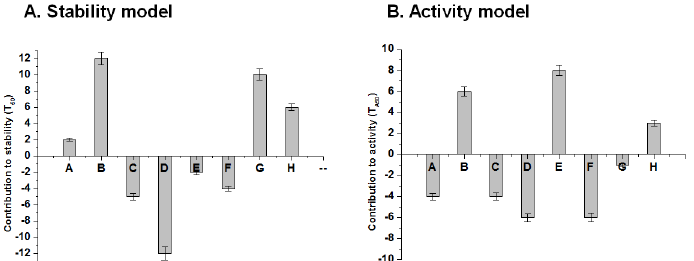
Fig 2. Modeling of thermostability and thermoactivity of GH5 chimeras. (A) Stabilizing or destabilizing effects of 8 noncontiguous blocks, relative to P2 (BsCel5A) for the T 50 model. Blocks A, B, G and H of P1 are predicted to be stabilizing, but replacement of C, D, E and F had negative effects on thermostability. (B) Stabilizing or destabilizing effects of 8 noncontiguous blocks, relative to P2 for the T A50 model. Blocks B, E and H of P1 are predicted to be stabilizing.